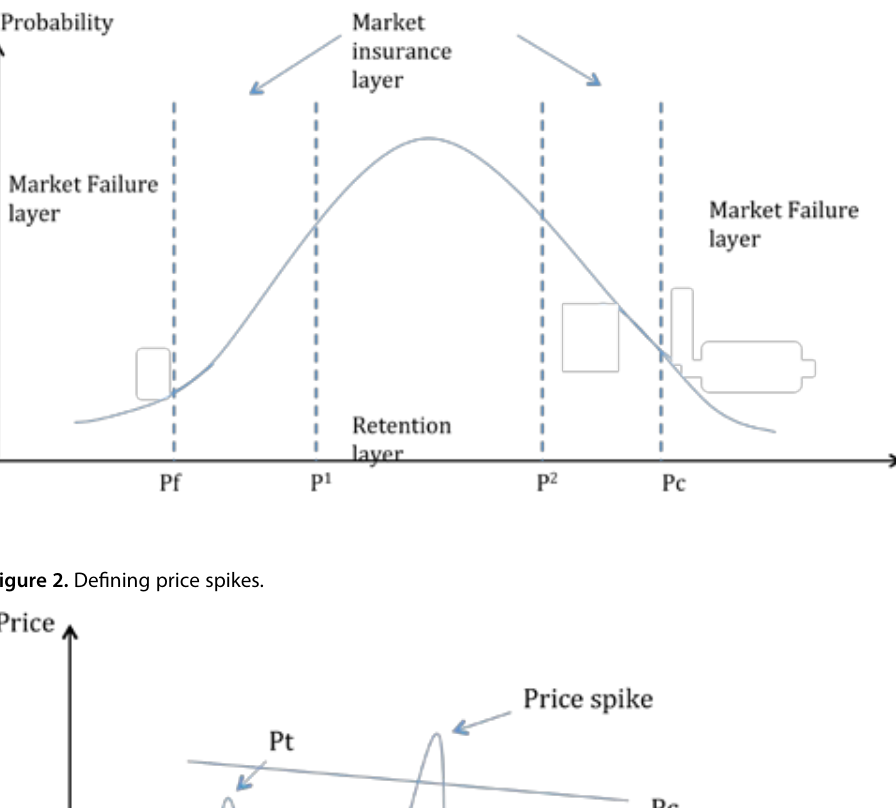
Figure 1. “Risk layers” of market prices.